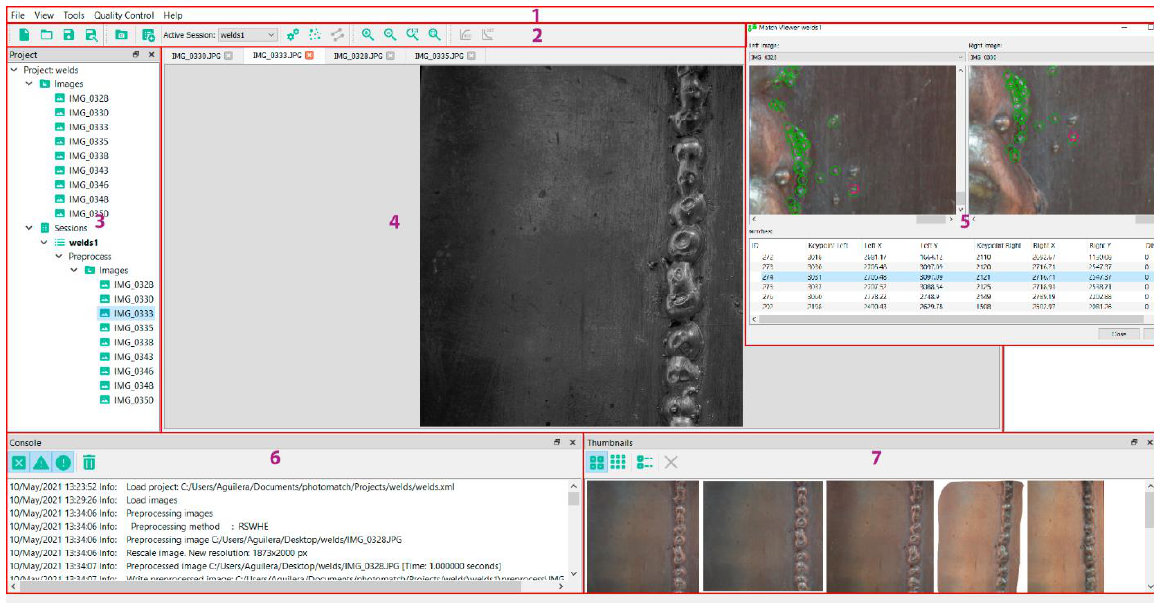
Figure 4. Stereoscopic photogrammetric arm composed by two reflex cameras (Canon EOS 700D) with two macro-lens (EF-S 60 mm).